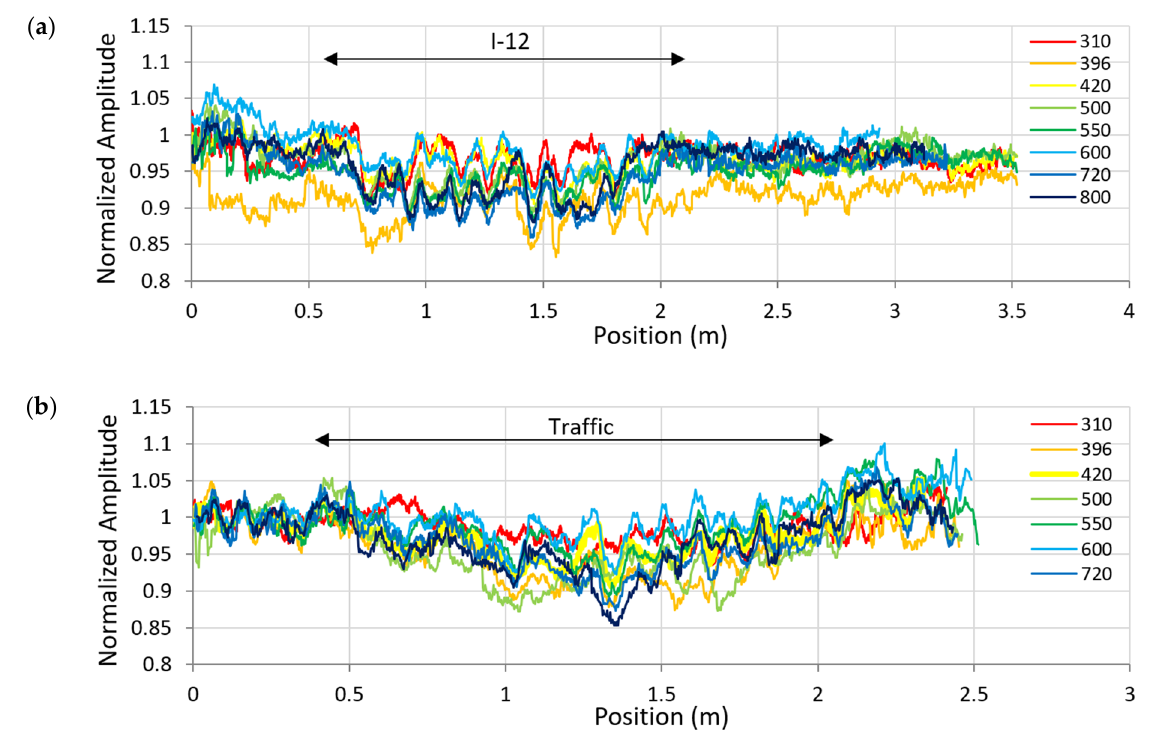
Figure 23. 2.6 GHz Norm. DW amplitudes on geotextile (I-12) in the ( a ) long. and ( b ) transv. direction vs. K loadings.